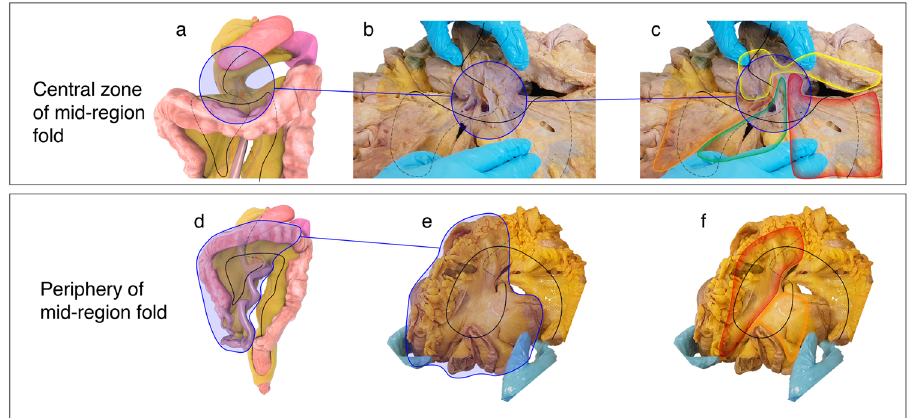
Fig. 4 Mid region of the mesentery. Photographs demonstrating the anterior aspect of the central zone (encircled) of the mid-region in ( a ) a digital and ( b ) ex vivo mesentery. In ( c ) a schematic has been superimposed on ( b ) explaining the underlying anatomy. colour code: pancreas (yellow), right mesocolon (orange), hepatic fl exure (green), splenic fl exure (red). Photographs demonstrating the anterior aspect of the peripheral zone (blue boundary) in ( d ) a digital model and ( e ) the ex vivo mesentery. In ( f ) a schematic has been superimposed on ( e ) explaining the underlying anatomy. colour code: original left side of the peripheral zone (red), original right side of the peripheral zone